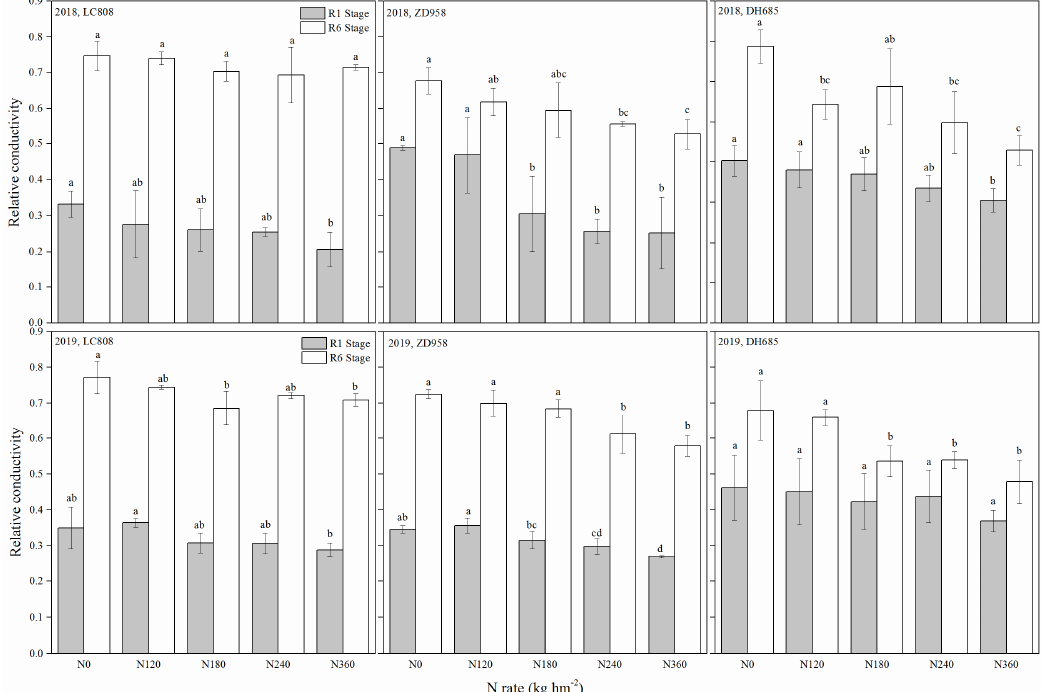
Figure 5. Relative conductivity of the different stay-green types of maize under different N levels. Additional letters represent significant differences ( P < 0.05) at the same growth stage between the different N rates. Error bars indicate the SD.